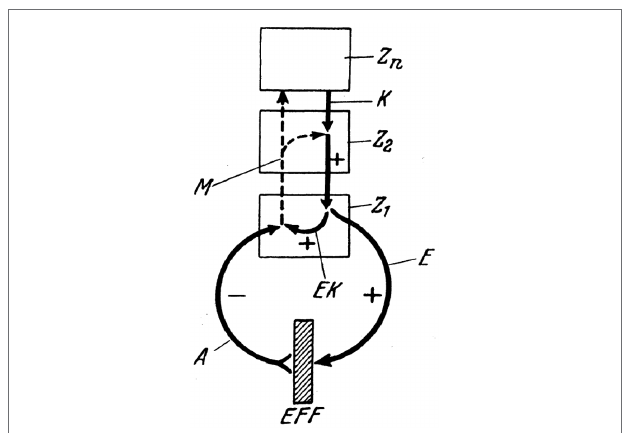
FIGURE 1 | General schema for the principle of reafference. From a higher center Zn a command K is sent to a lower center (Z2); from there a neuronal command is given to an executive center (Z1), which in turn innervates (by an efference E) an effector (EFF). Simultaneously, a copy of the efferent command E is stored [efference copy (EK)]. After the movement, an afferent signal A (or the “reafference”) is sent to Z1, where this reafferent signal is compared with the EK. If A (with a minus sign) resembles to EK (with a plus sign), both signals cancel each other, and the sensorimotor cycle is completed. If EK and A do not match, a message (M) is sent to Z2 and Zn to correct or to re-initiate the sensorimotor cycle until it ultimately comes to an end. Reproduced from von Holst and Mittelstaedt (1950/1971), with permission from